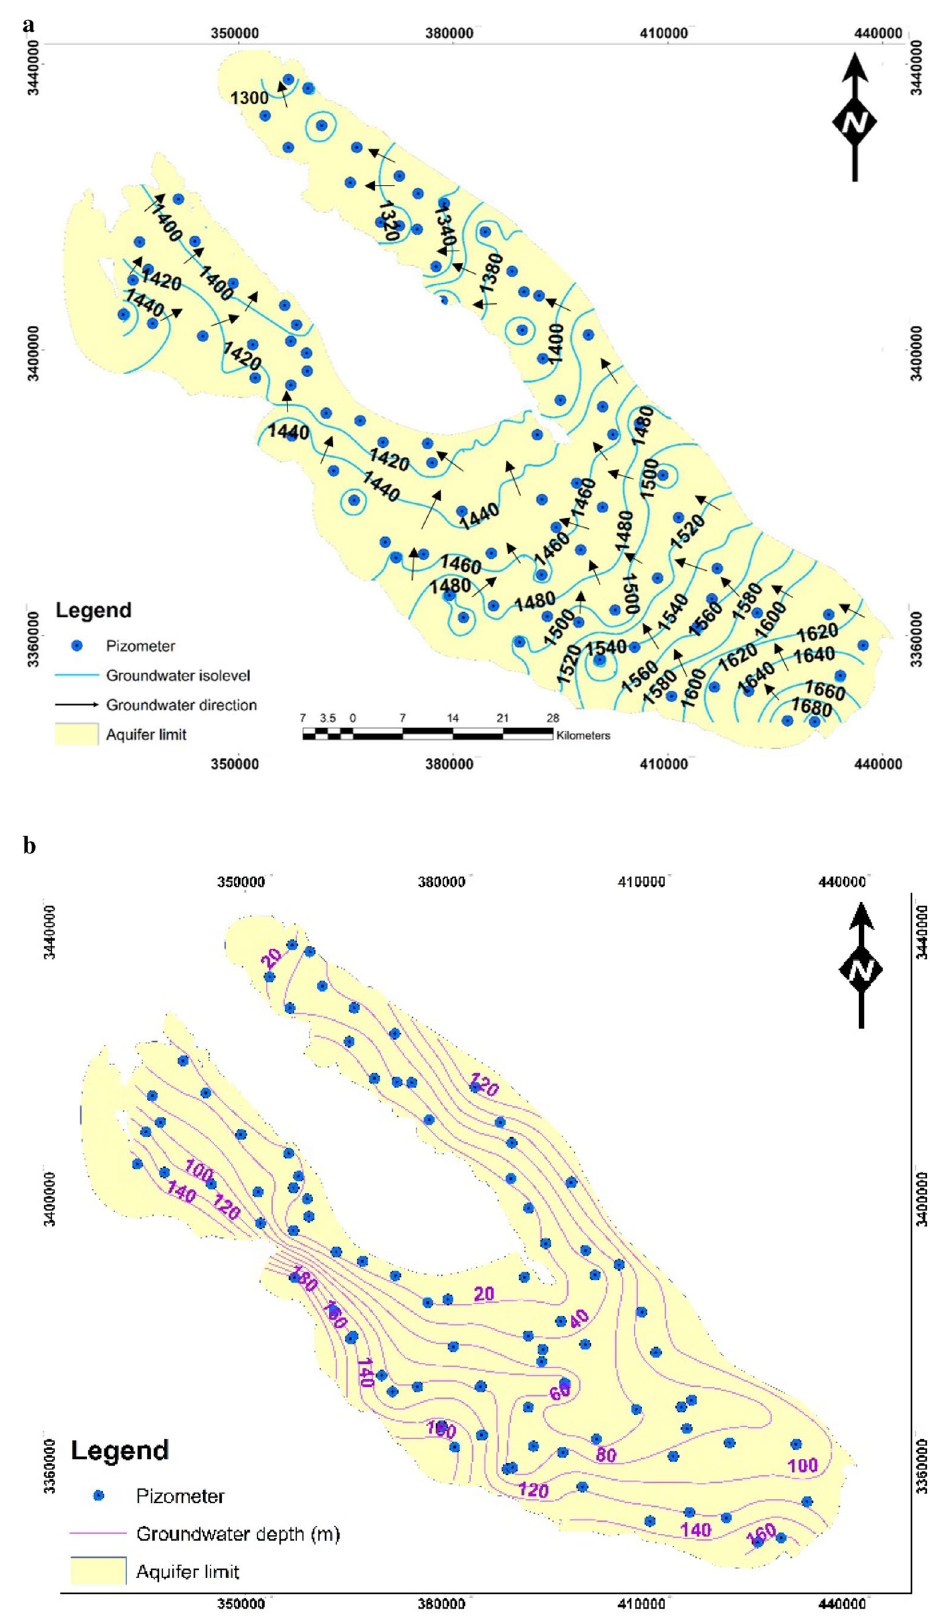
Fig. 3 a Groundwater flow direction and b groundwater depth in the study